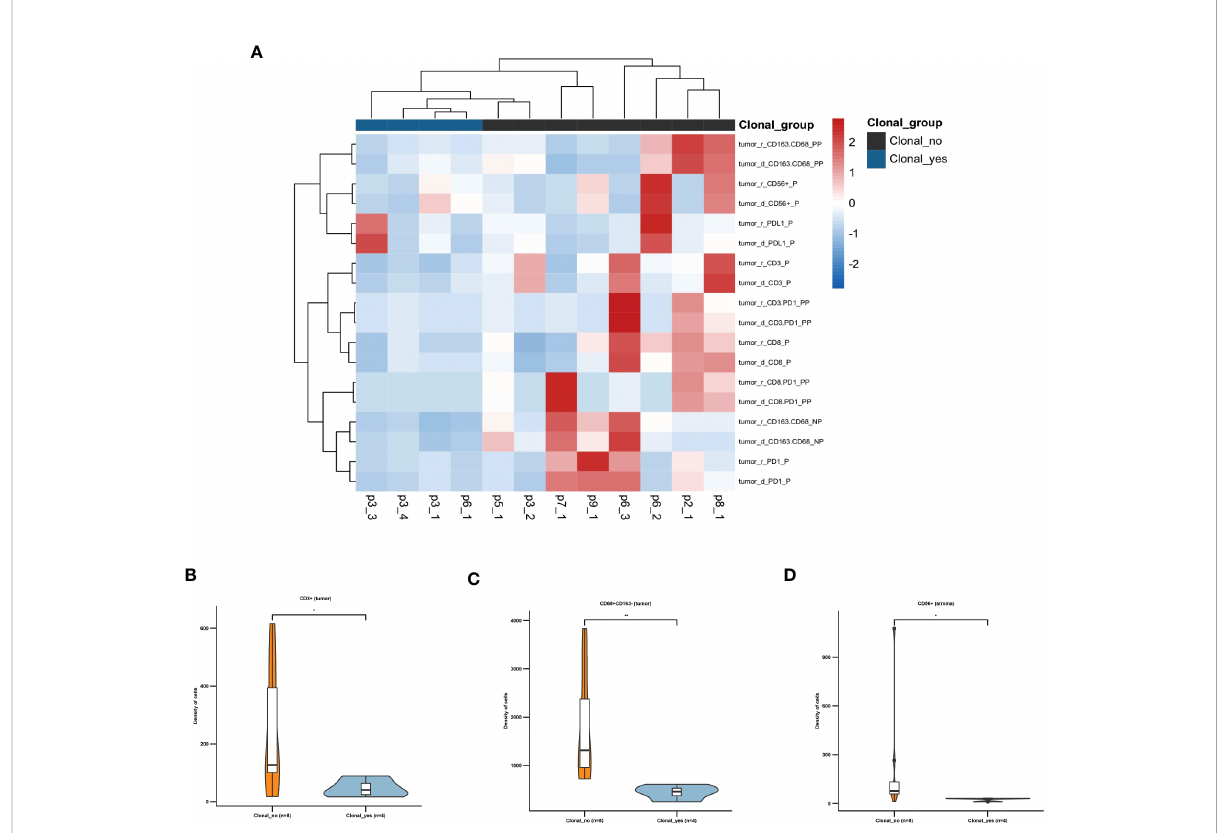
FIGURE 6 TME is associated with the pattern of clonal origin of recurrent tumors (A) The heat map shows the density and positive cell rate of seven key immune markers, PD1, PD-L1, CD3, CD8, CD56, CD 68, and CD163, in tumors of patients with recurrence. (B) The density of CD3+